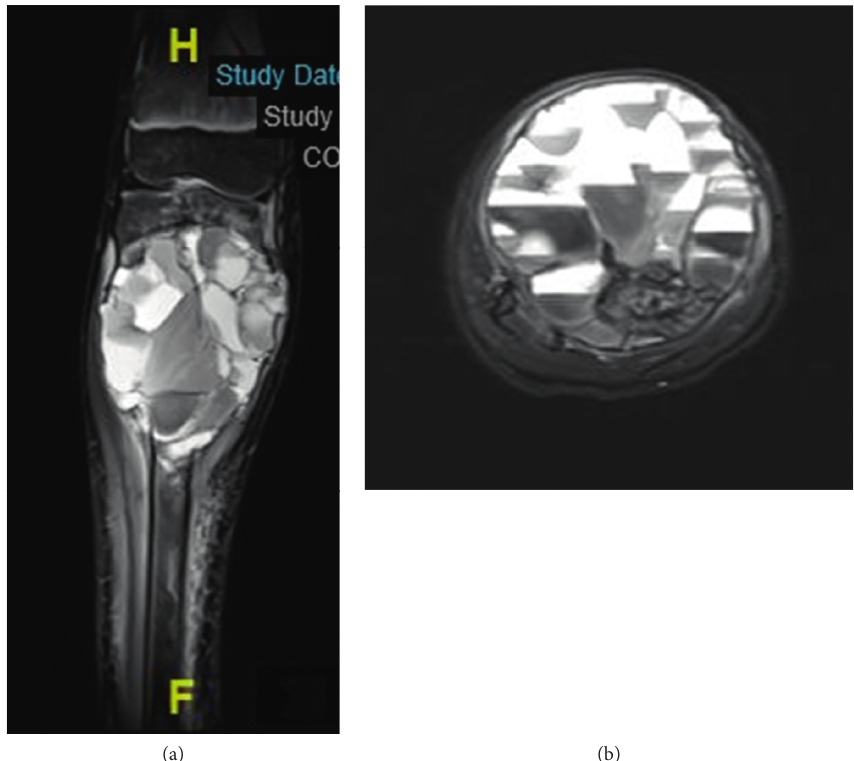
Figure 2: Coronal (a) and axial (b) T2 weighted MRI images of the tibia showing a large recurrent